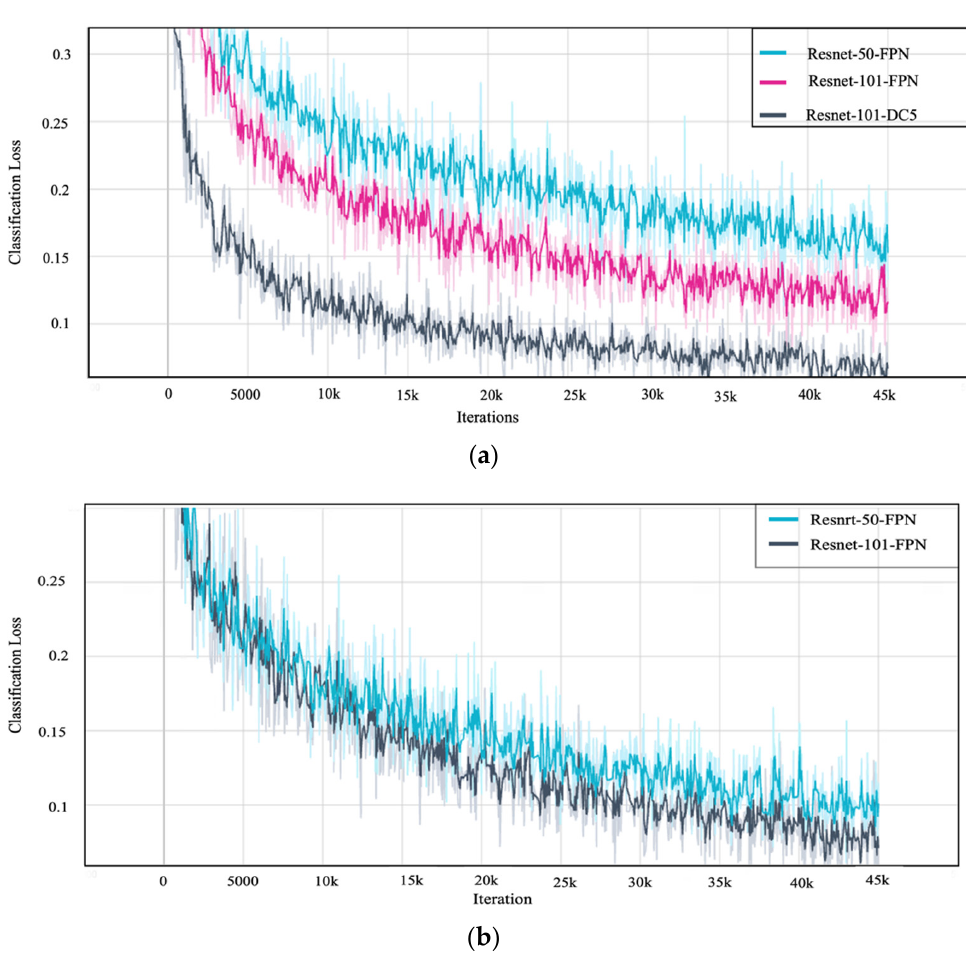
Figure 8. Training and classification loss of ( a ) Faster R-CNN models and ( b ) RetinaNet models.